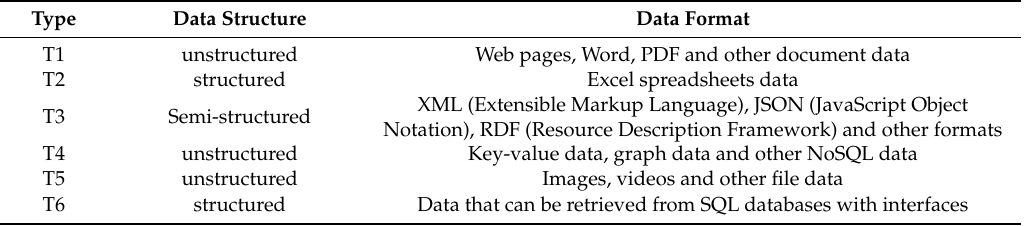
Table 1. Classification of material data according to data format and structural